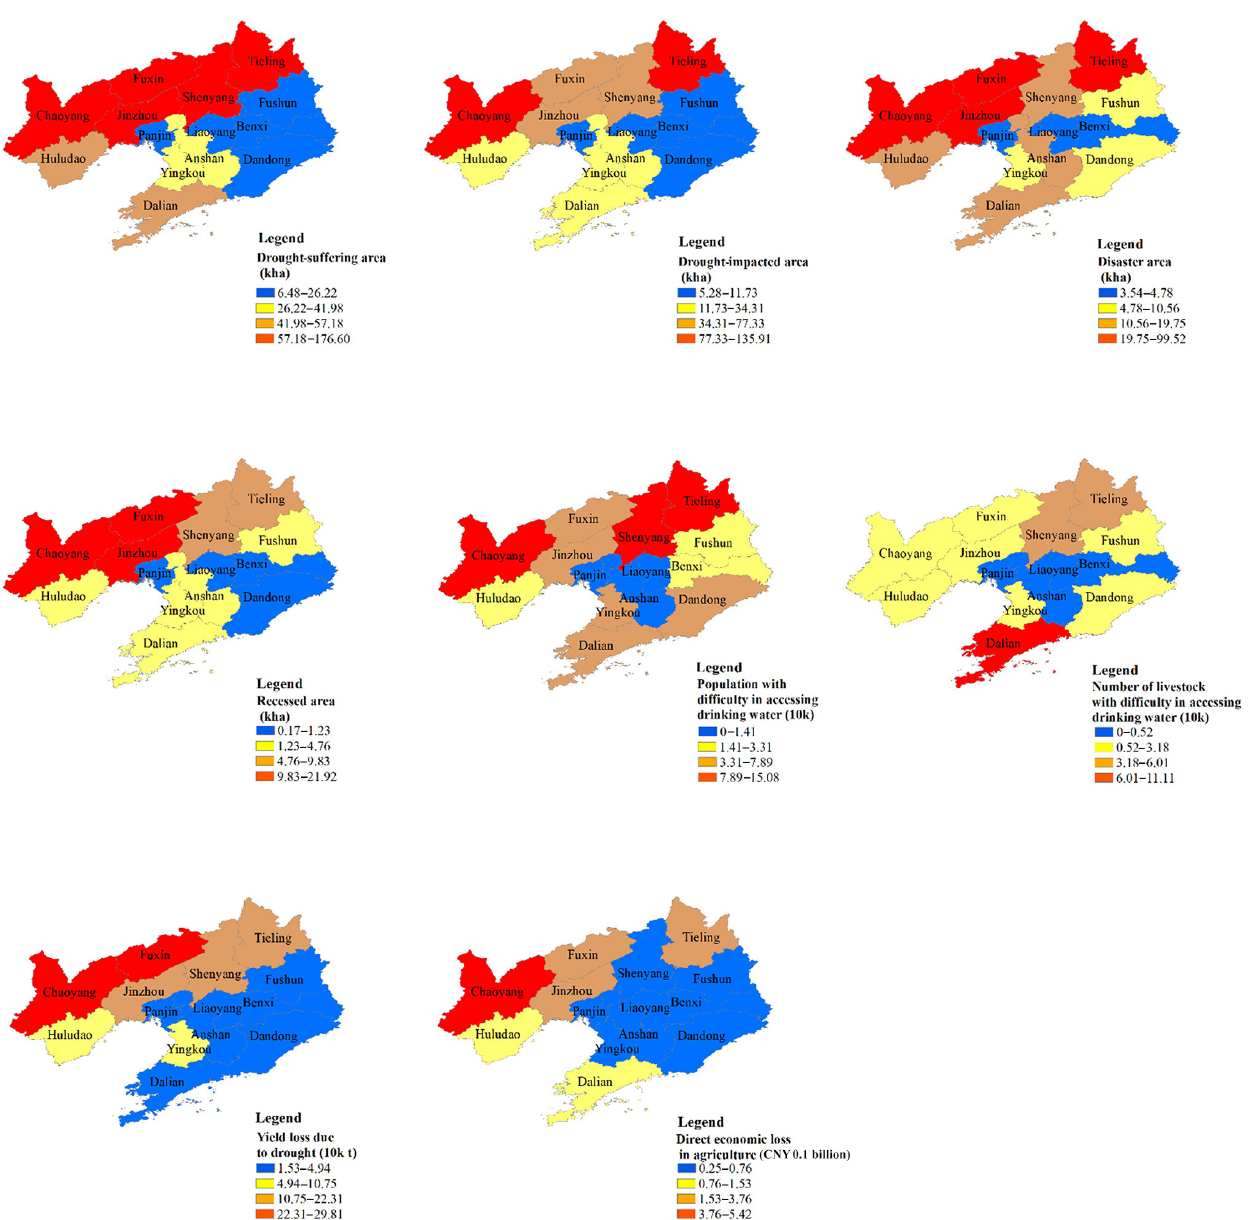
Figure 3. Distribution of average drought impacts for each impact type, identified by the codes in Table 1, for the period 1990–2016 in Liaoning